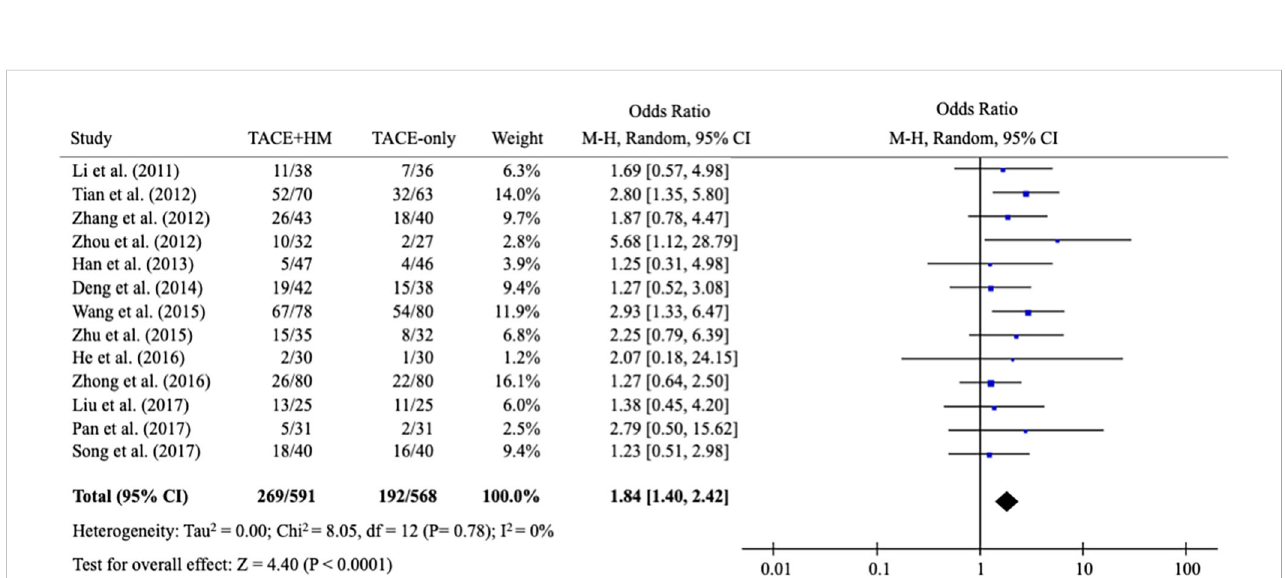
FIGURE 7 Meta-analysis of the number of complete response/partial